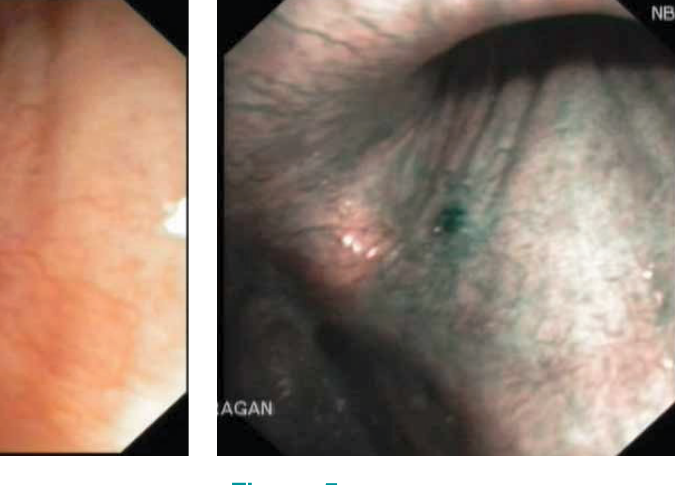
Figure 4. Needle biopsy being performed on the site of